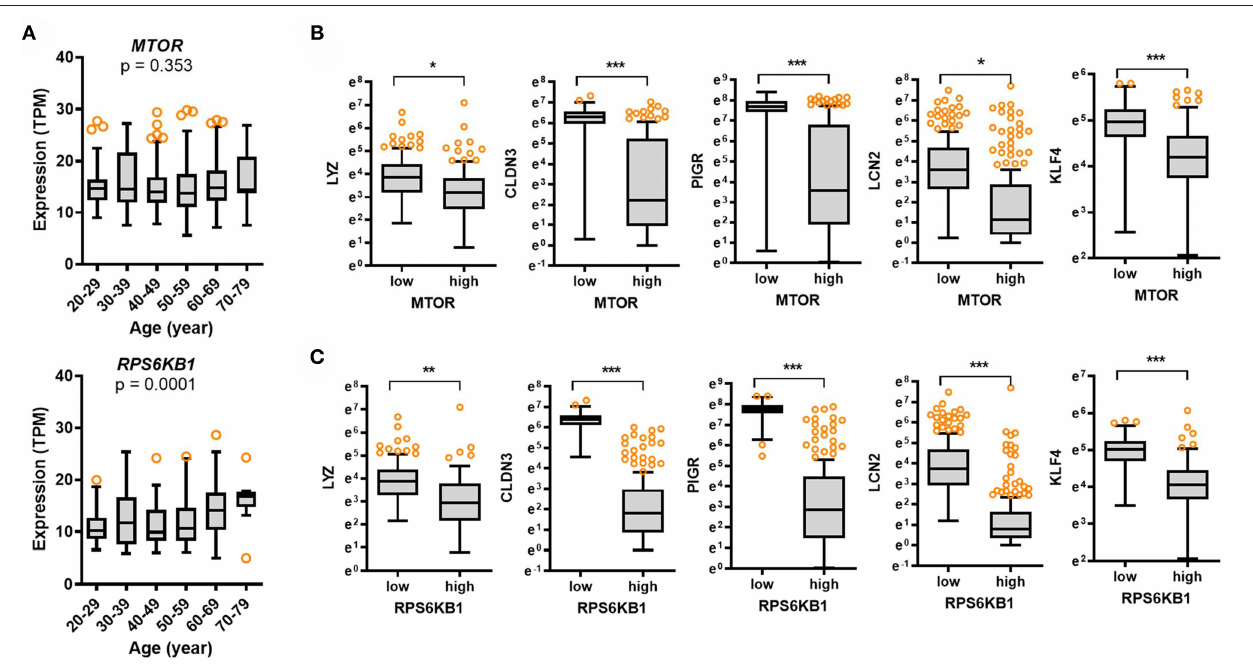
FIGURE 5 | Expression of cell metabolic stress markers and their association with gut defense biomarkers with age. (A) Results are depicted as box-and-whisker plots (Turkey) for expression of cellular metabolic stress markers ( mTOR or RPS6KB1 ) in normal mucosal intestinal tissues (GTEx dataset v8). Values are presented as transcripts per million (TPM). Statistical significance of the expression variation with age is illustrated on the top of each plot (Kruskal–Wallis test). (B,C ) Considering the mTOR (B) or RPS6KB1 (C) levels, we selected the 150 highest and 150 lowest level samples, which were further evaluated based on LYZ, CLDN3, PIGR, and LCN2 levels. Values are presented as natural logarithm of TPM. Asterisks (*) indicate significant differences from the low expression group (* p < 0.05, ** p < 0.01, *** p <